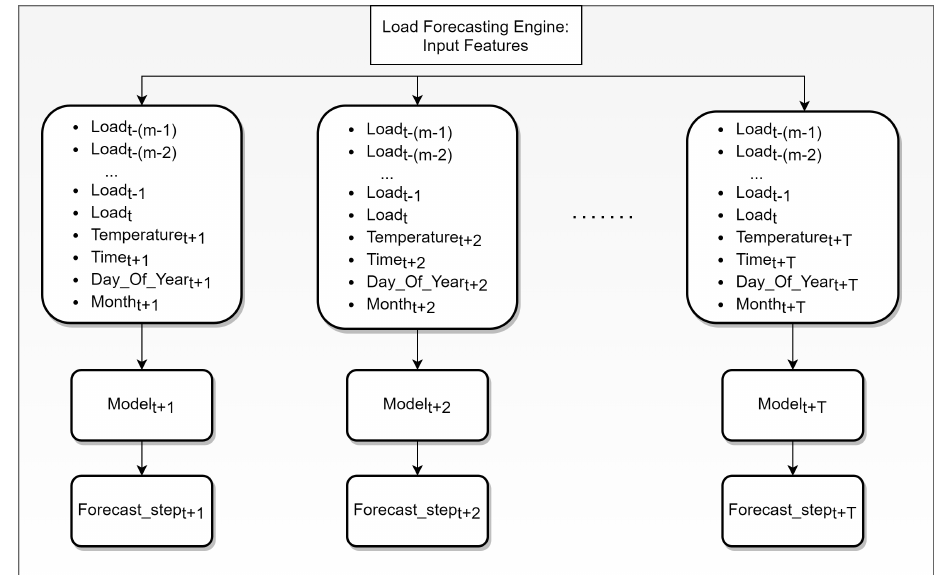
Figure 3. Framework for direct multi-step day-ahead load